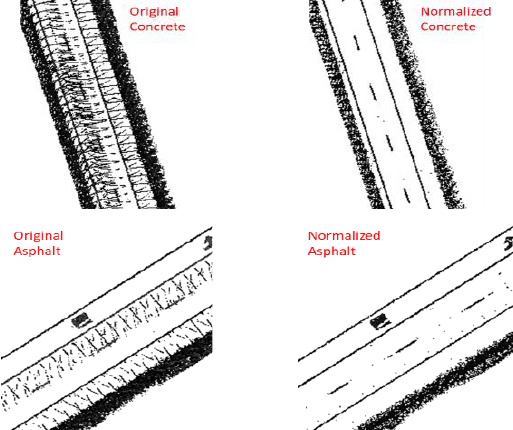
Figure 9. Hypothesized lane markings derived through original and normalized intensity thresholding strategies in concrete and asphalt pavement area for dataset